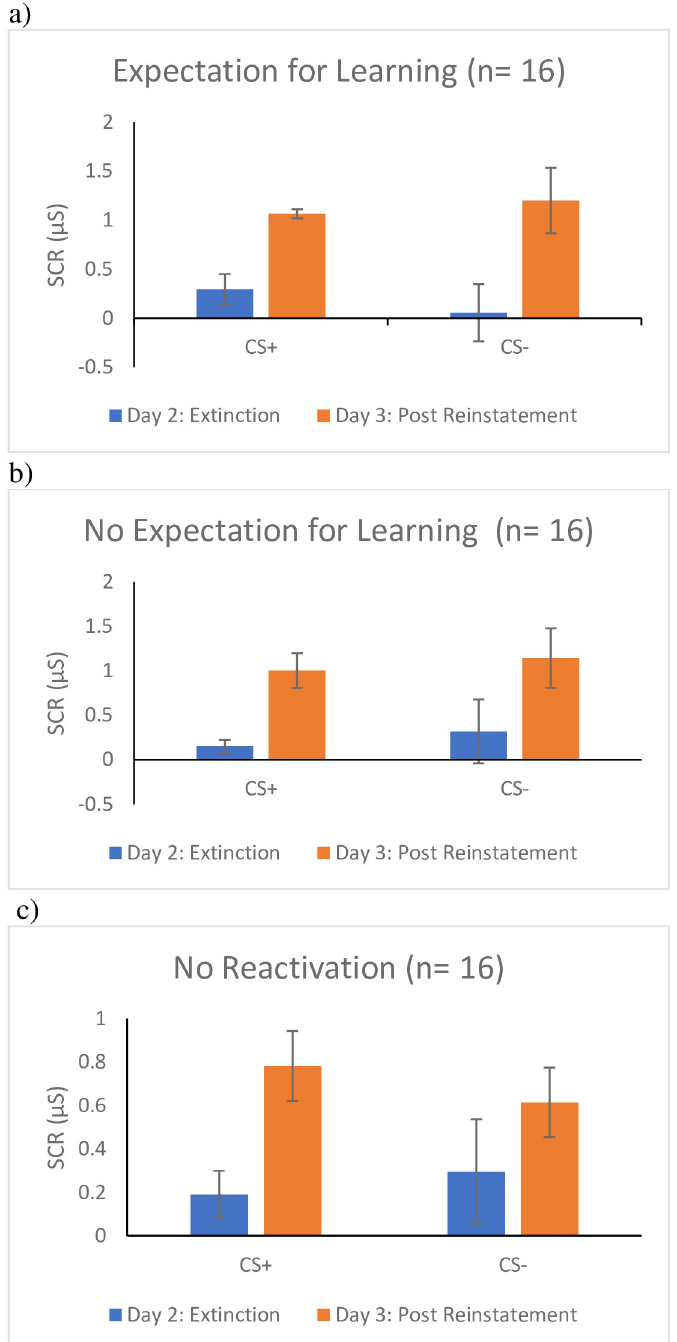
Fig 3. Return of fear following reinstatement as measured by SCR for the a) Expectation for learning group, b) the no Expectation for learning group, and c) the No reactivation group. Note . Results for skin conductance (SCR) for reconsolidation. Day 2 is a measure of fear following extinction (i.e., last trial of extinction). Day 3 is a measure of fear following reinstatement of fear (i.e., first trial of re-extinction). Measures of SCR were taken at every presentation of a